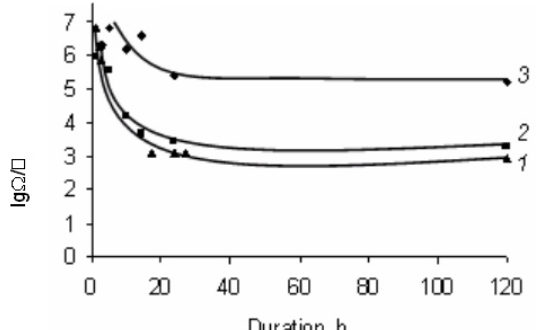
Figure 20. Dependance of Log sheet resistance of chalcogenide layers on PA surface on the exposure time. The